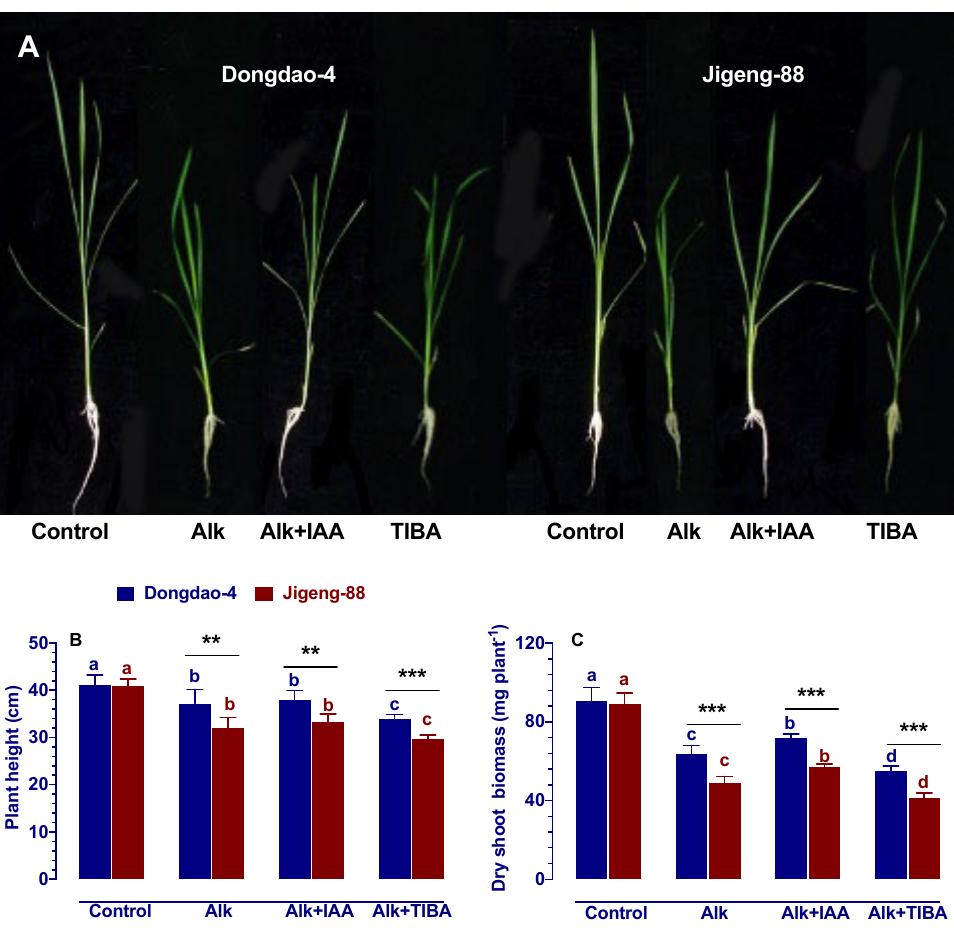
Figure 2. Effects of IAA and TIBA on ( A ) symptoms, ( B ) plant height, ( C ) dry shoot biomass of Dongdao-4 and Jigeng-88 seedlings after treatment with alkaline stress. Treatments were as described in Figure 1. Means with different letters are significantly different ( p < 0.05) between control and “Alk” and “Alk + IAA” and “Alk + TIBA” of the same genotype. Asterisks indicate significant differences between different genotypes within the same treatment (** p < 0.01, *** p < 0.001).